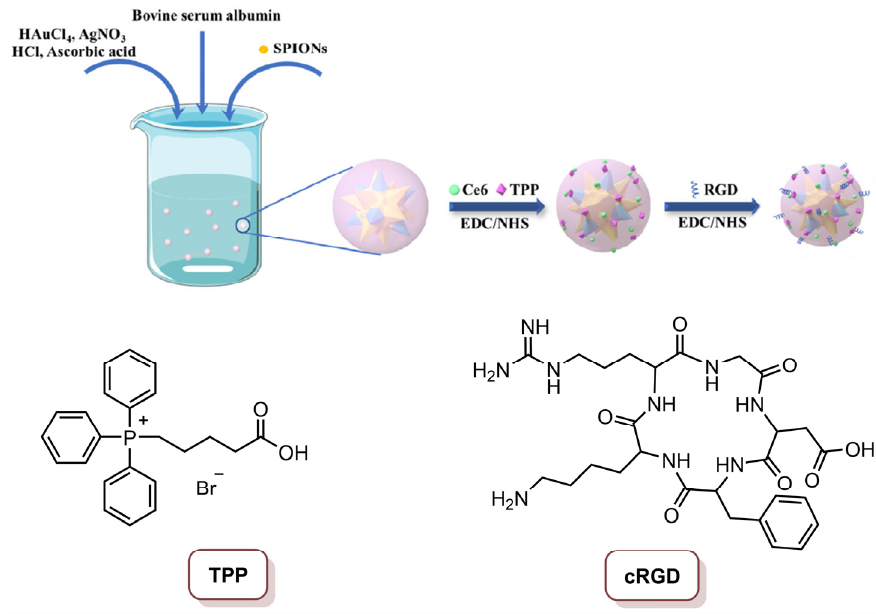
Figure 15. Schematic representation of the multifunctional magnetic gold nano-heterostructure loading Ce 6 and functionalized with cRGD peptide and TPP molecule (Ce 6 @MGN@RT) (reproduced from Reference [22] with permission from Elsevier).